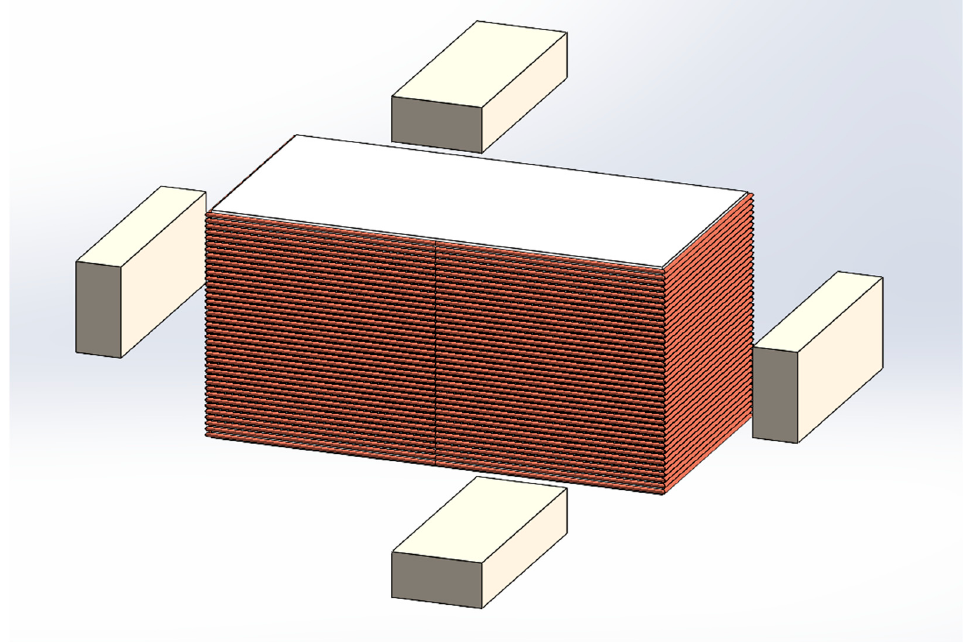
Figure 5. Arrangement of tank with horizontally wound coil.